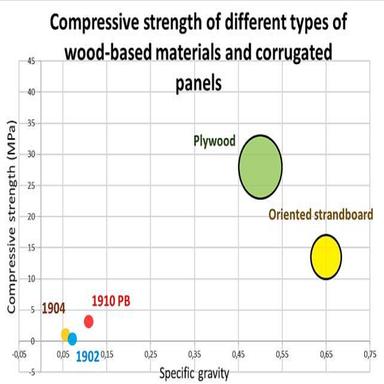
Compressive strength of different types of wood-based materials and corrugated panels .